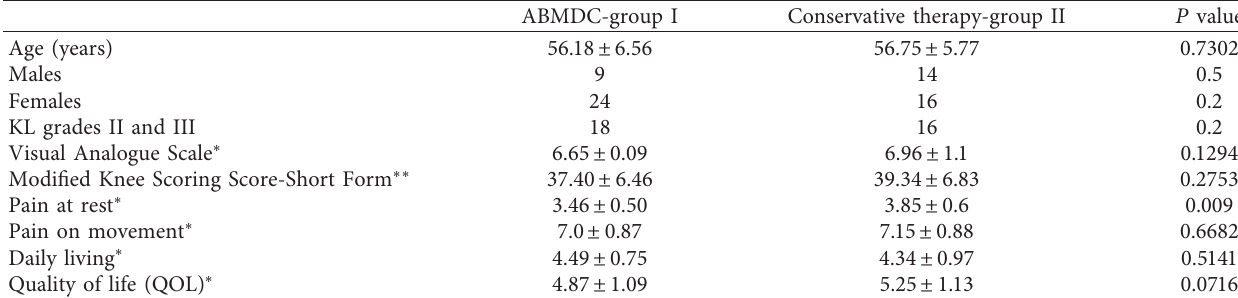
Table 1: Demographic data of baseline